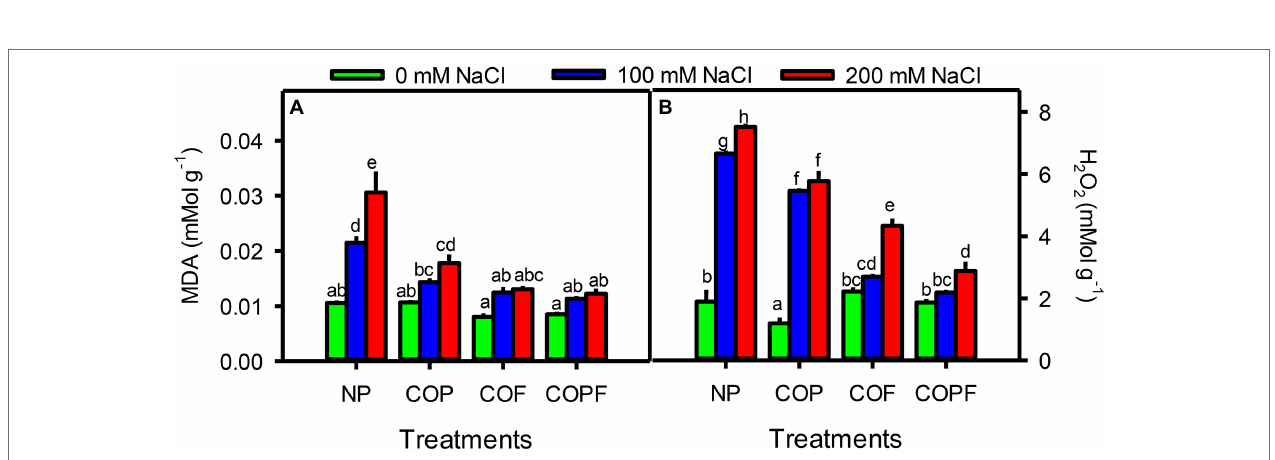
FIGURE 5 | Effect of salinity and coumarin applications on stress markers MDA (A) and H 2 O 2 (B) . Plants were treated with 0 mg L − 1 coumarin (NP), 100 mg L − 1 coumarin as seed priming (COP), 100 mg L − 1 coumarin as foliar application (COF) and combined treatment (COPF), under 0, 100 and 200 mM NaCl. Values are represented as means ±SE ( n = 3). Different letters represent significant differences ( p < 0.05) by Tukey’s HSD